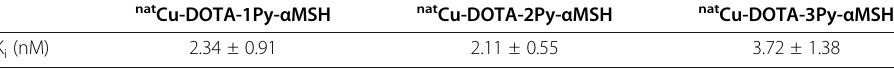
Table 2 Inhibition constants (K i ) of nat Cu-DOTA-xPy- α MSH (x = 1 – 3) towards MC1R ( n =